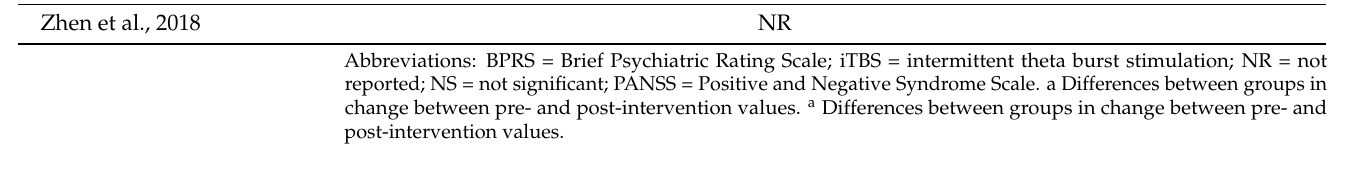
Table 4. Rates of dropout and adverse